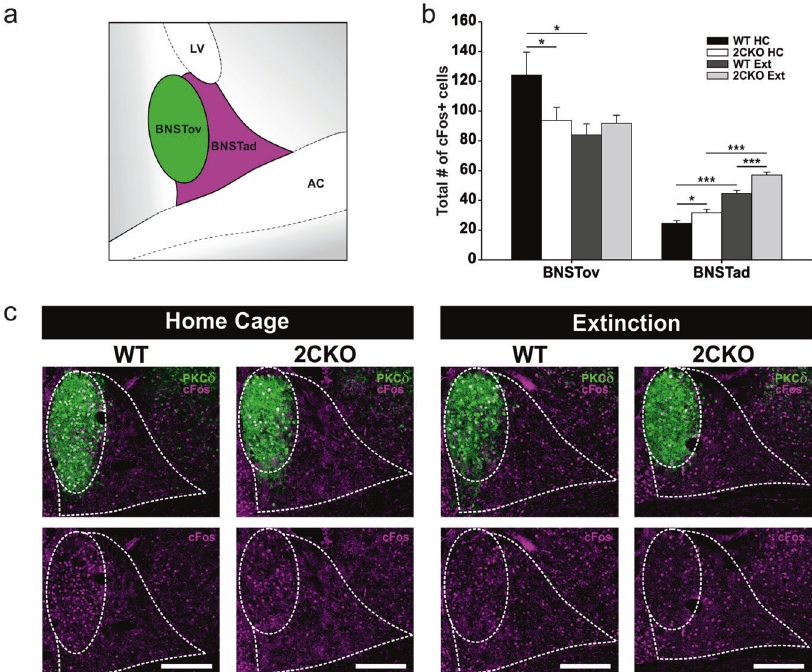
Fig. 3 Altered neuronal activity in the dorsal BNST supports faster fear extinction in 2CKO mice. a Schematic illustration of the dorsal BNST subregions analyzed. BNSTov bed nucleus of the stria terminalis, oval nucleus; BNSTad bed nucleus of the stria terminalis, anteriodorsal part; LV lateral ventricle; AC anterior commissure. b cFos quanti fi cation in the BNSTov and BNSTad. In the BNSTov, 2CKO mice showed reduced cFos levels under home cage conditions and extinction treatment reduced cFos in WT mice: Two-way ANOVA (treatment): F (1,19) = 4.973, P = 0.038; pairwise Holm – Sidak test: WT HC vs. 2CKO HC: P = 0.036, WT HC vs. WT Ext: P = 0.011. In the BNSTad, 2CKO mice showed increased cFos levels under home cage and extinction conditions and extinction treatment increased cFos in both genotypes: Two-way ANOVA (genotype): F (1,19) = 20.736, P ≤ 0.001; Two-way ANOVA (treatment): F (1,19) = 114.923, P ≤ 0.001; pairwise Holm – Sidak test: WT HC vs. 2CKO HC: P = 0.034, WT Ext vs. 2CKO Ext: P ≤ 0.001, WT HC vs. WT Ext: P ≤ 0.001, KO HC vs. KO Ext: P ≤ 0.001. HC: WT mice ( n = 5), 2CKO mice ( n = 6); Ext: WT mice ( n = 5), 2CKO mice ( n = 7). Data are shown as means ± SEM. * P < 0.05, *** P < 0.001. c Representative immuno-stained BNST sections. PKC δ (green), used as a marker for the BNSTov subregion, in combination with cFos (magenta). Scale bars = 200 (Fig. 5e) to reveal between group effects. Final animal numbers are mentioned in the fi gure legends. For all results, the level of signi fi cance was set to P < 0.05. All data are expressed as mean ± SEM.